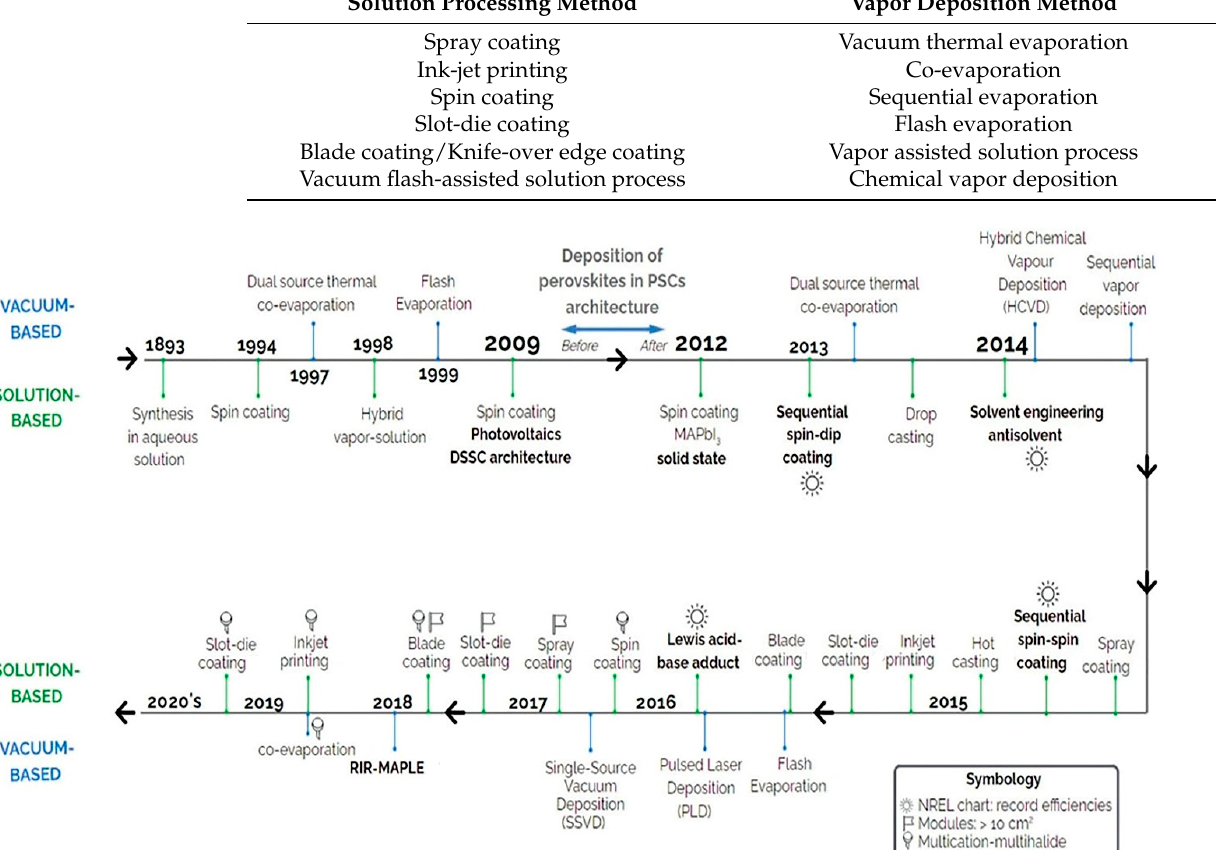
Figure 3. Timeline for application of vacuum deposition methods vs. solution processing methods in the fabrication of inorganic and mixed halide perovskites. The symbology legend defines fabrication methods used; reported National Renewable Energy Laboratory (NREL) record efficiencies, modules, and multi-cation/multi-halide compositions [42]. Copyright 2020 American Institute of Physics. Table 1. Large-area perovskite thin-film fabrication methods used in the current work [15,17,23,40,41,43].